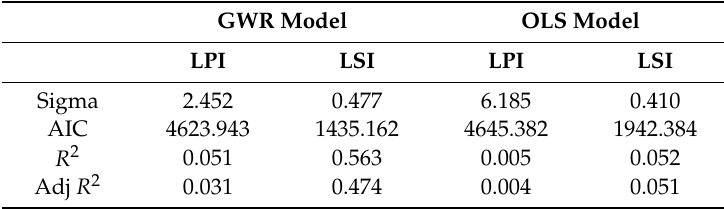
Table 5. Simulation results for the geographically weighted regression (GWR) and ordinary least squares (OLS)